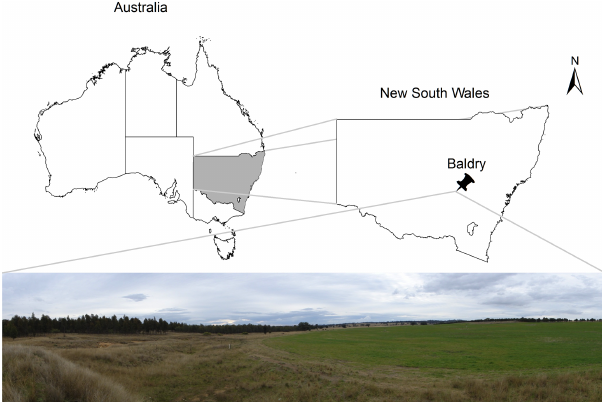
Figure 1. Location of the Baldry study area in the central west of NSW Australia, along with a photograph of the study